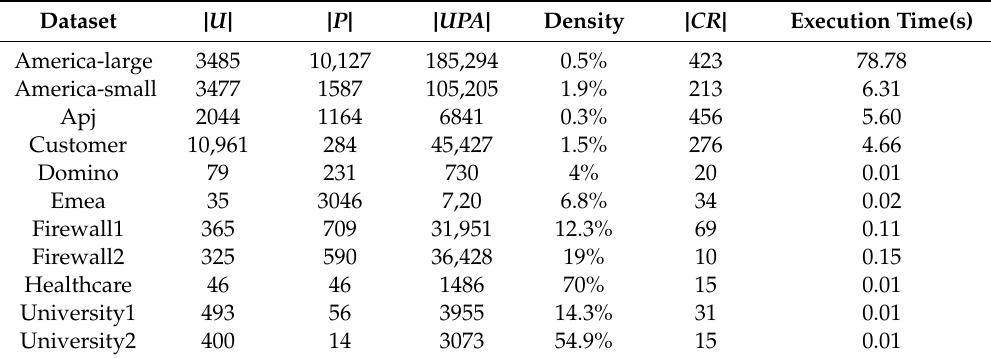
Table 18. Original